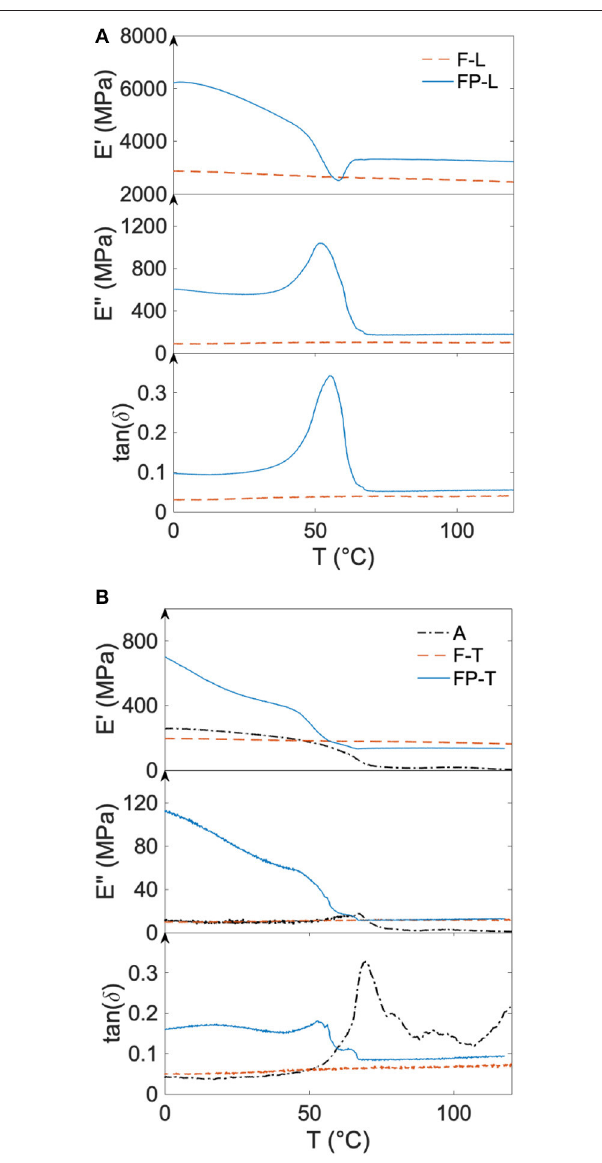
FIGURE 5 | DMA thermograms of the constituents, showing the storage modulus E ′ , the loss modulus E”, and the loss factor tan δ . (A) Samples F and FP (longitudinal direction); (B) samples F, FP (transversal direction), and A.